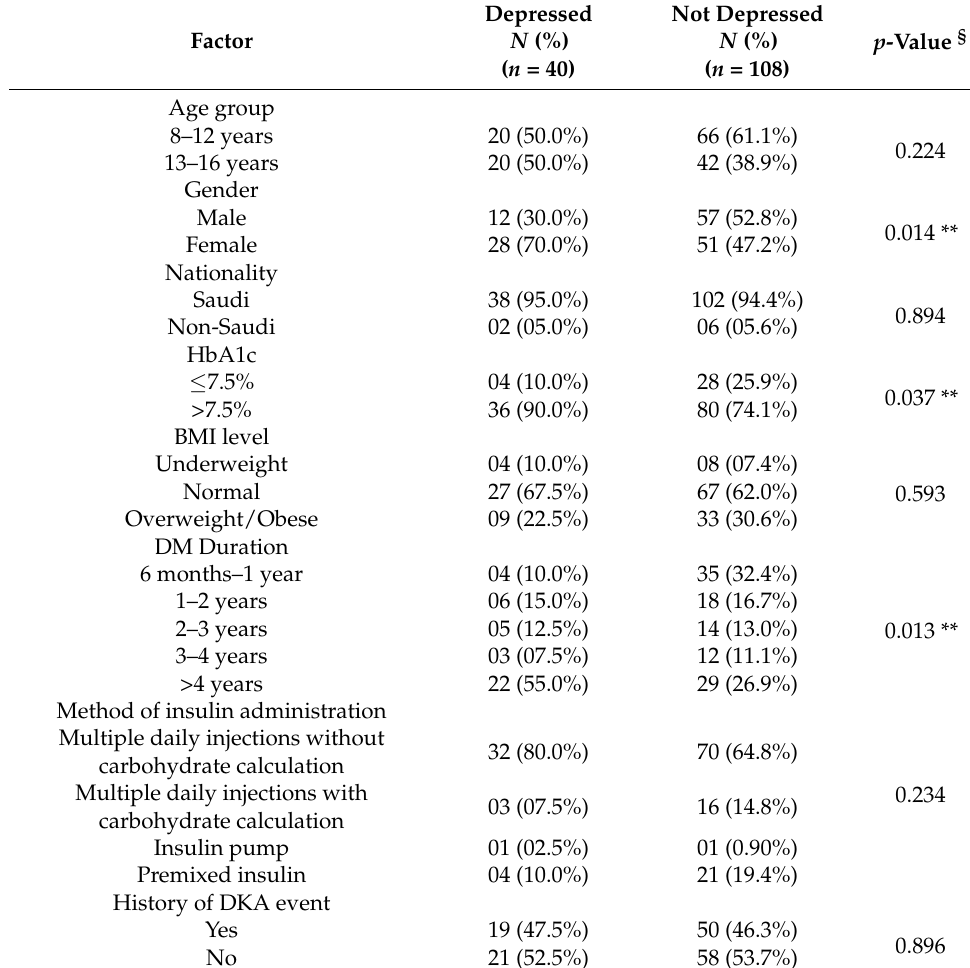
Table 3. Relationship of depression level and socio-demographic profiles with hypoglycemic, DKA events, and measurement of blood glucose levels per day ( n =